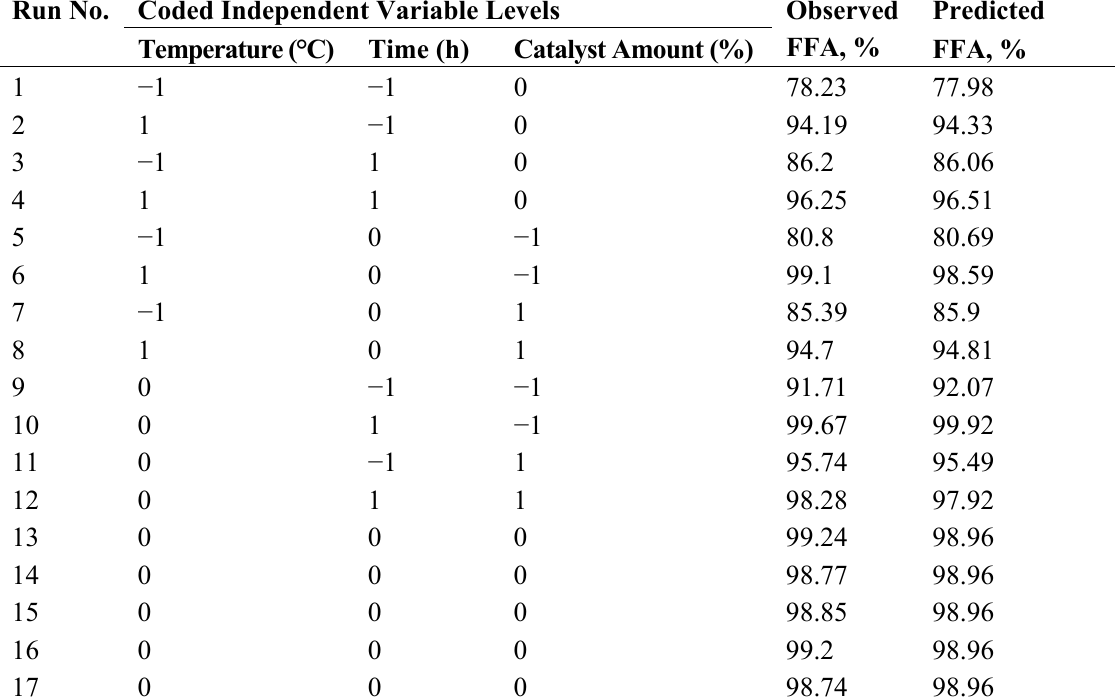
Table 2. Box-behnken design optimization of lacquer wax hydrolysis. Run